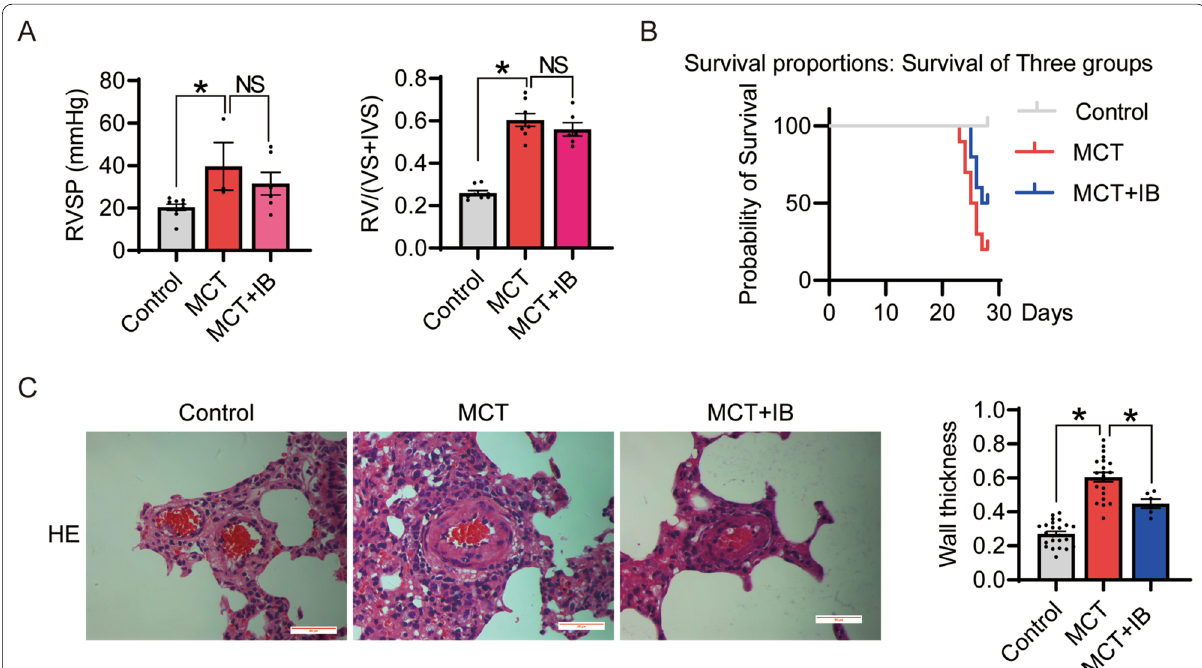
IVS) in control, PAH and IB treated groups. n 3–9 + = 4–10 per group. C Hematoxylin and eosin staining of lung tissues. The index of wall = 6–24 per group. Scale bar 50 μm. Data are expressed as the mean SEM. All experiments were = = ±